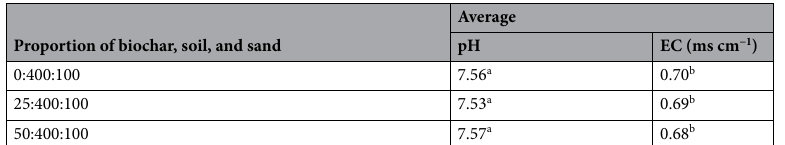
Table 5. Average pH and EC of plants grown in the soil mixtures comprising different proportions of biochar, soil collected from Klong 4, 5, and 6, and sand. We performed the measurement after 23 days of cultivation (different lowercase letters in the column indicate significant differences at the P < 0.05 level following two-way ANOVA analysis and DMR test).